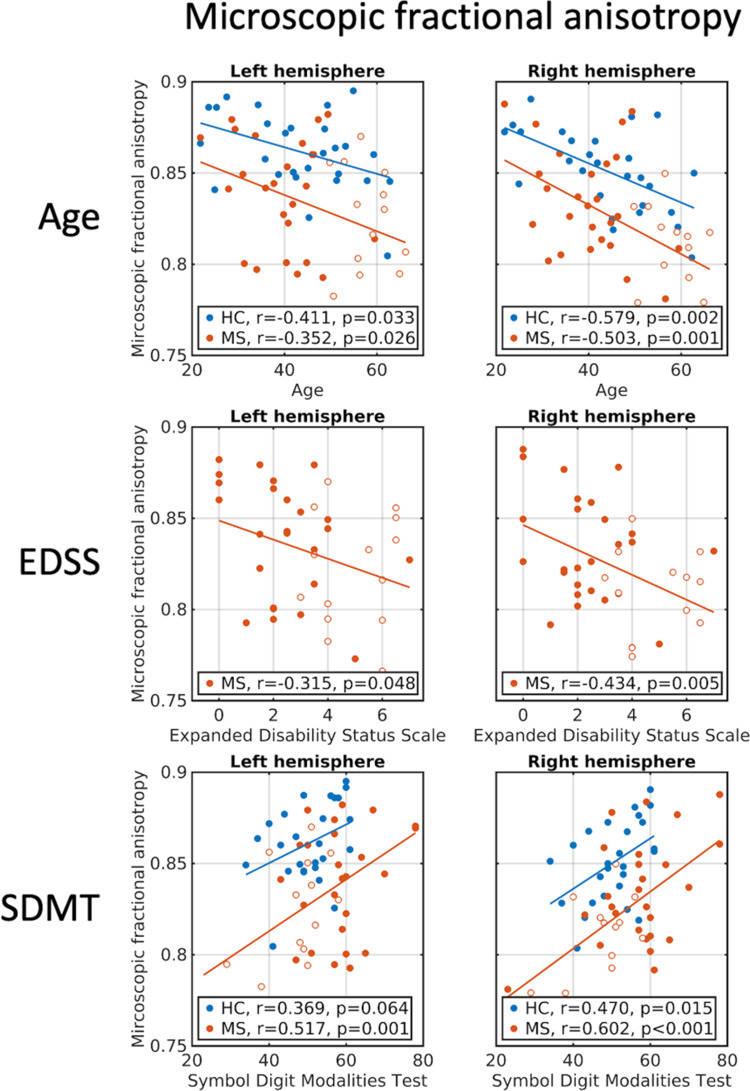

Correlations between μFA and clinical/cognitive scores. Age, EDSS and SDMT correlations with μFA averaged within left and right hemispheres of NAWM. First row: correlations with age. Second row: correlations with EDSS. Third row: correlations with SDMT. Blue circles: healthy controls. Full red circles: relapsing-remitting multiple sclerosis patients. Open red circles: primary-progressive multiple sclerosis patients. EDSS = expanded disability status scale; SDMT = symbol digit modalities test.